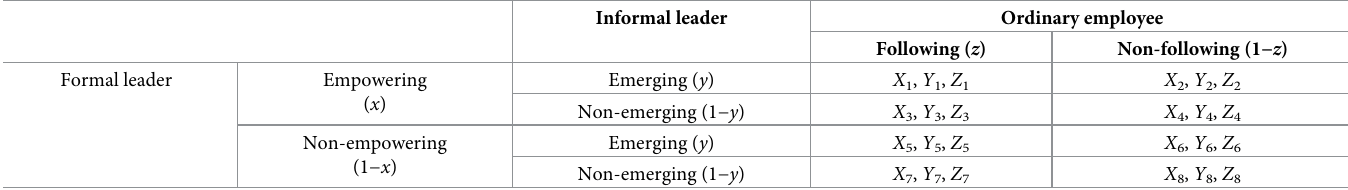
Table 2. Strategy matrix of tripartite evolutionary